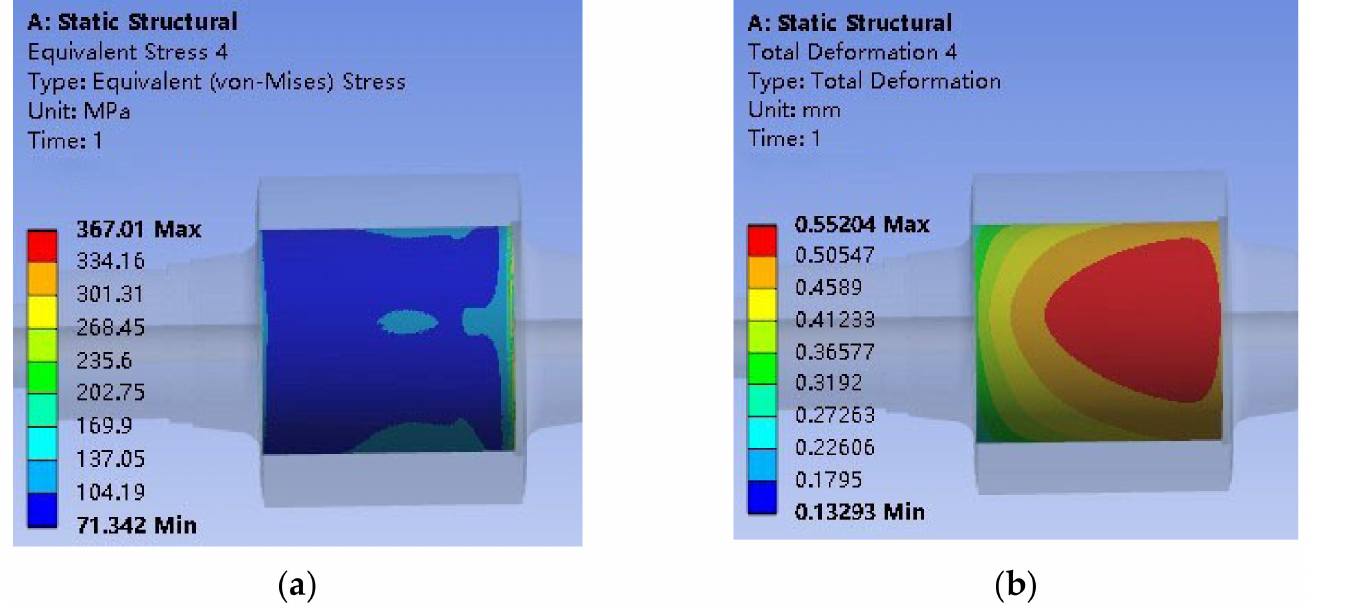
Figure 10. Simulation nephograms of roller shaft: ( a ) equivalent stress nephogram; ( b ) total deformation